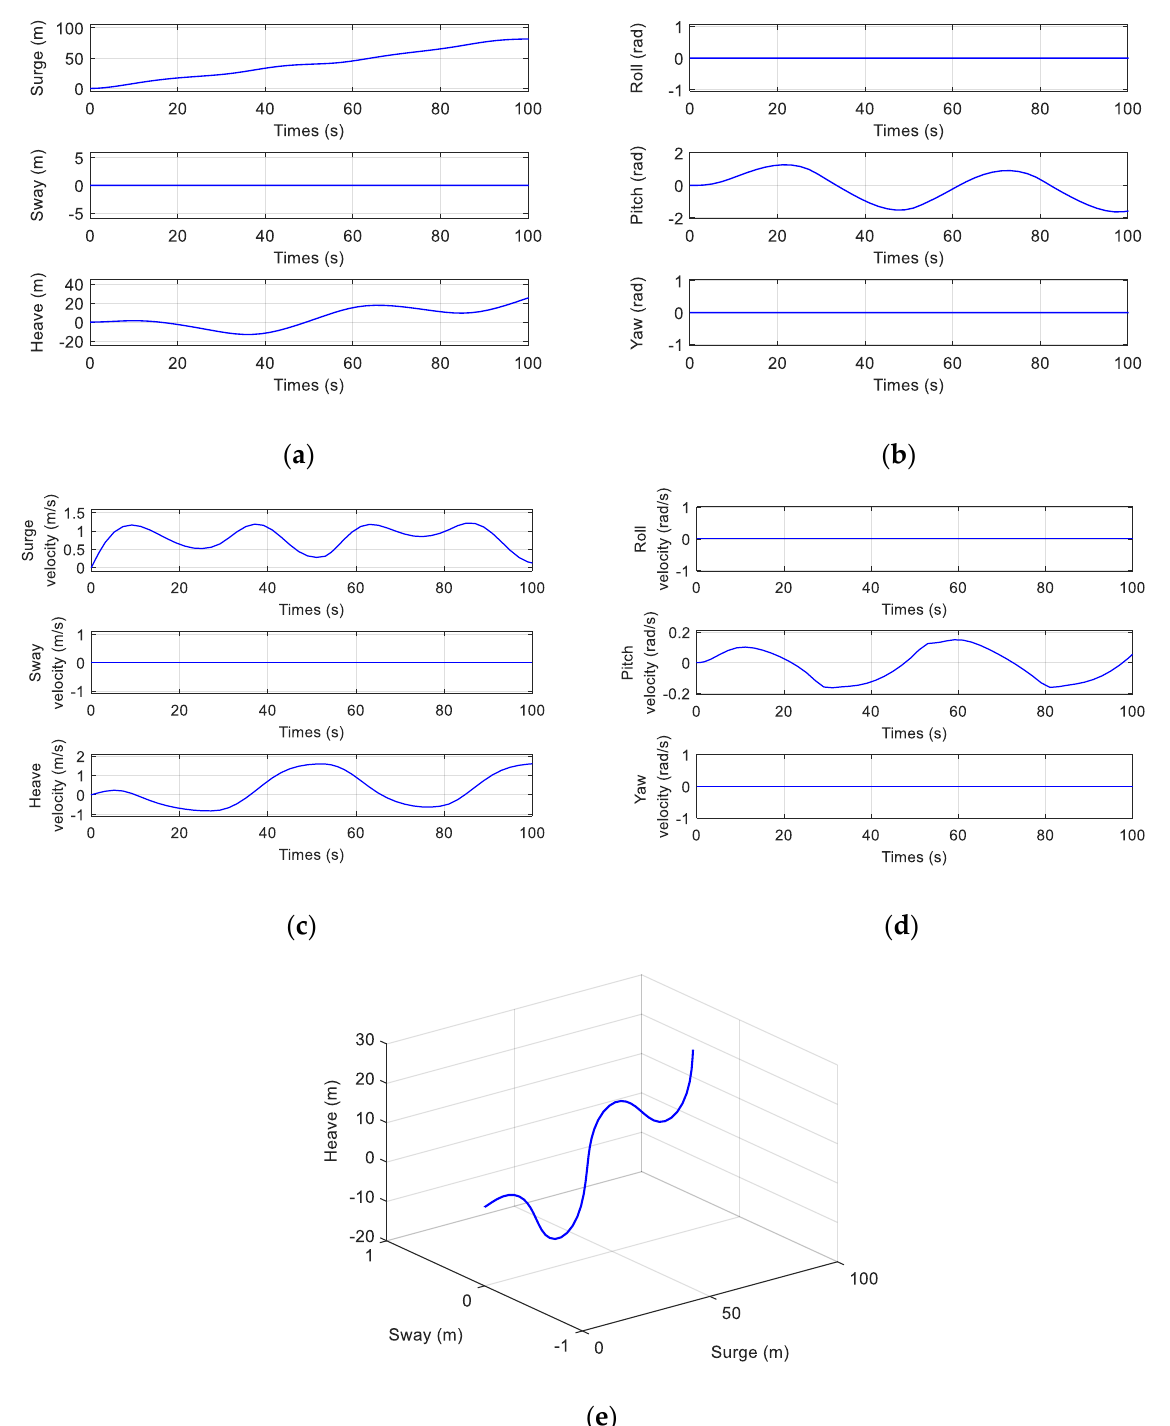
Figure 5. Pitching motion of MJ-AUV: ( a ) Position changes over time; ( b ) Attitude changes over time; ( c ) Linear velocity changes over time; ( d ) Angular velocity changes over time; ( e ) 3D motion.